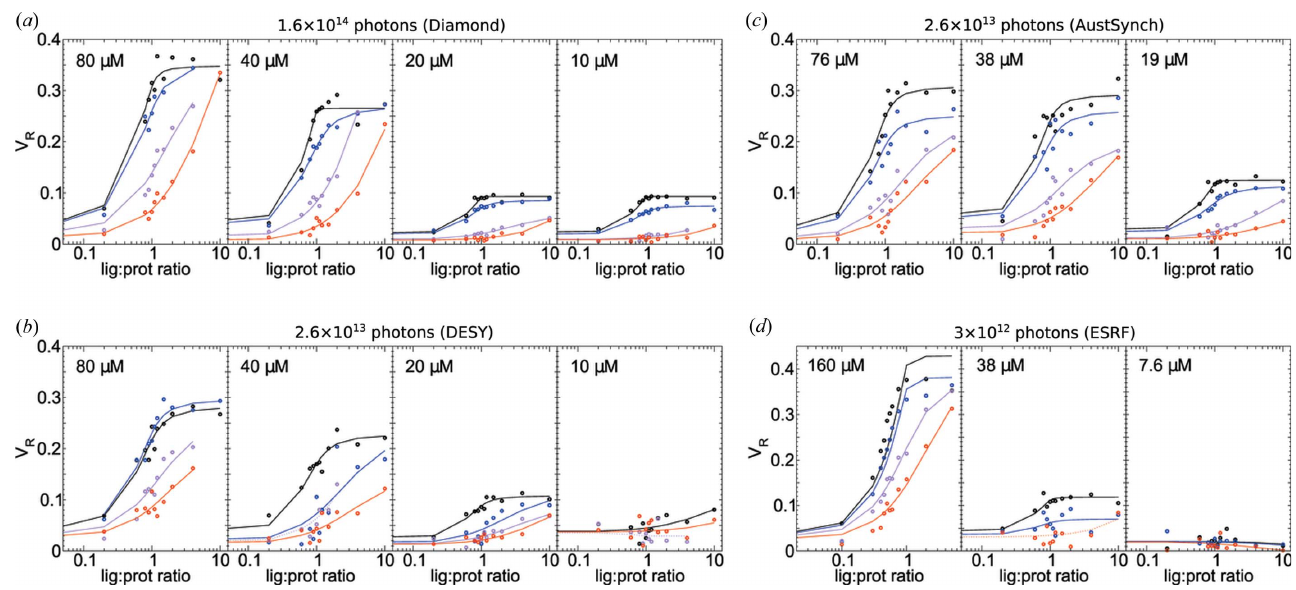
Figure 4 Replicate V R titration curves of HisBP against four ligands: His (black), Arg (blue), Lys (violet) and Orn (red). Data collected at various total doses: ( a ) 1.6 (cid:8) 10 14 photons at Diamond, N = 192; ( b ) 2.6 (cid:8) 10 13 photons at DESY, N = 172; ( c ) 2.6 (cid:8) 10 13 photons at Australian Synchrotron, N = 144; and ( d ) 3 (cid:8) 10 12 photons at ESRF, N = 144. The HisBP concentrations used within each experiment are labelled on respective plots. Note that the maximum q -range measured in ( d ) was 2.8 nm (cid:2) 1 , which affected the V R .